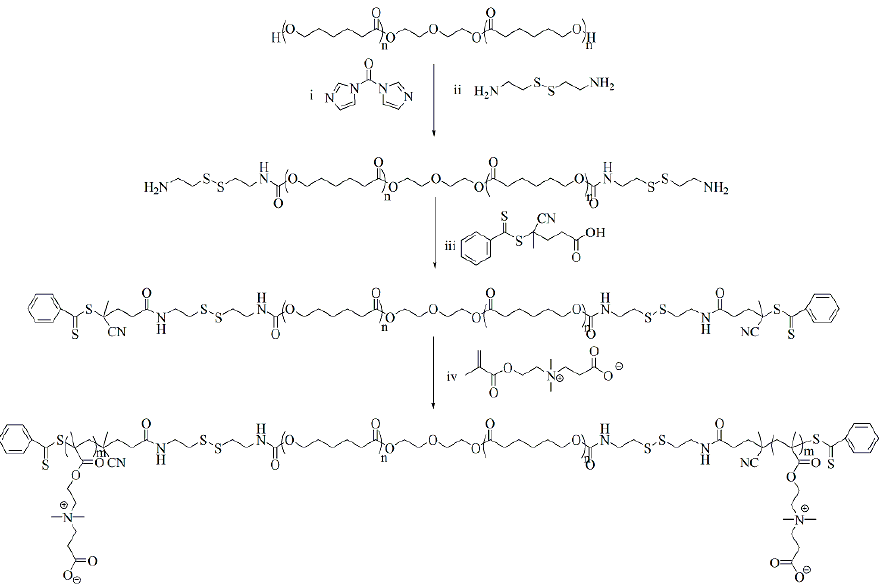
Scheme 2. Synthesis route of PCBMA-SS-PCL-SS-PCBMA. (i) CDI, anhydrous DCM, RT., 24 h; (ii)